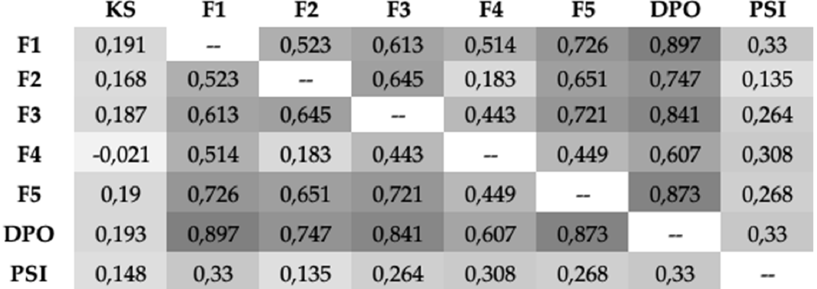
Figure 1. Pearson’s Correlations’ Heatmap. KS: Knowledge Score; DPO: Digital Psychiatry Opinion; PSI: Perceived Significance Index; F1: factor 1; F2: factor 2; F3: factor 3; F4: factor 4; F5: factor 5. Higher correlations are marked with darker shades, while lower correlations are marked with lighter shade.